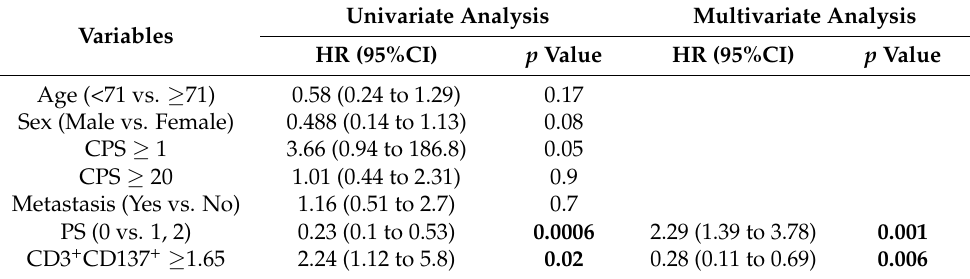
Table 3. Predictive and prognostic factors for overall